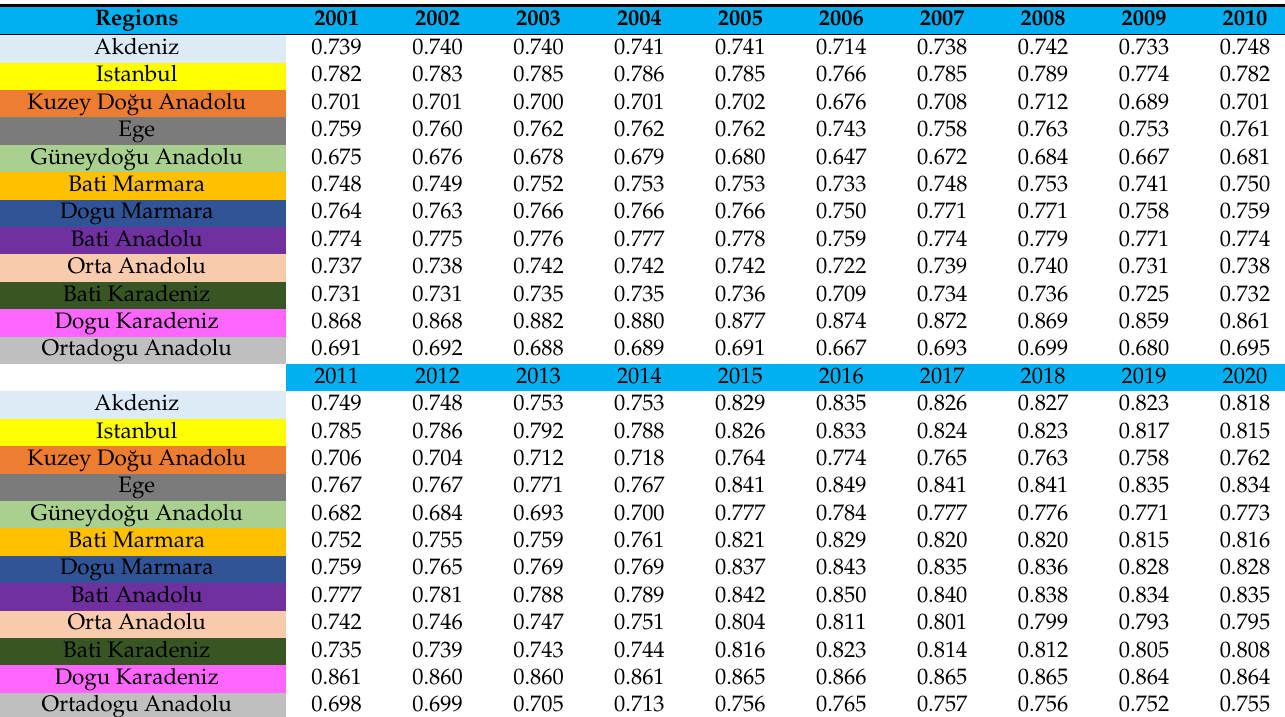
Table 13. Estimated regional human development index—Turkey 2001–2020.